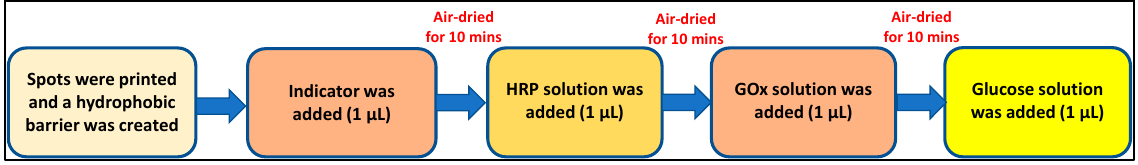
Figure 7. Schematic showing the reaction mechanism for glucose detection.